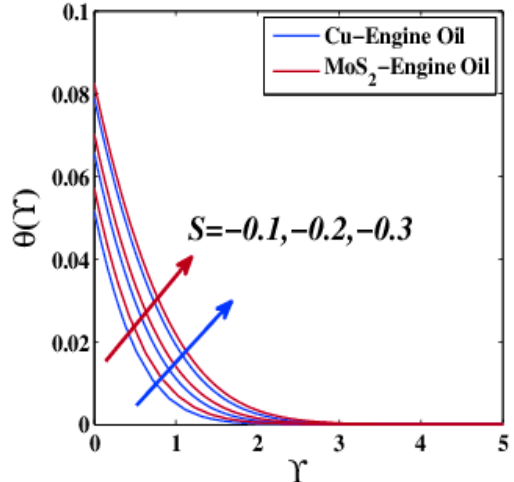
Figure 28. Temperature variation θ ( Y ) under the influence of S < 0.